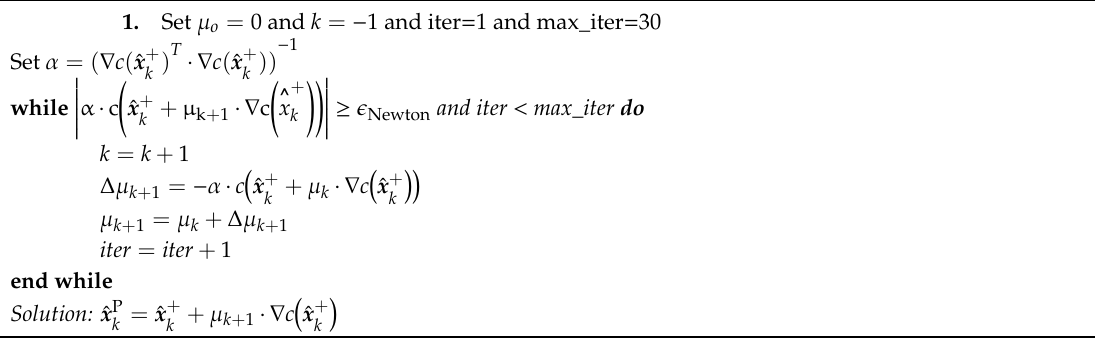
Algorithm A1. Simplified Newton descent search algorithm for constrained estimation projection. 1. Set µ o = 0 and k = − 1 and iter = 1 and max_iter =